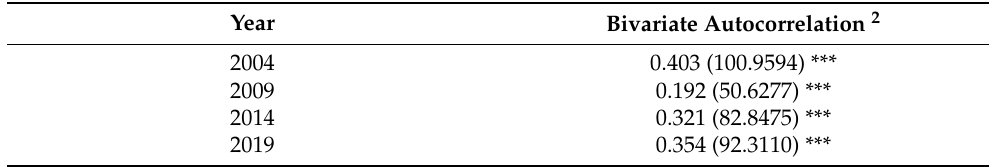
Table 9. Bivariate Moran‘s I statistics of the LST and NTL within the sixth ring road of Beijing from 2004 to